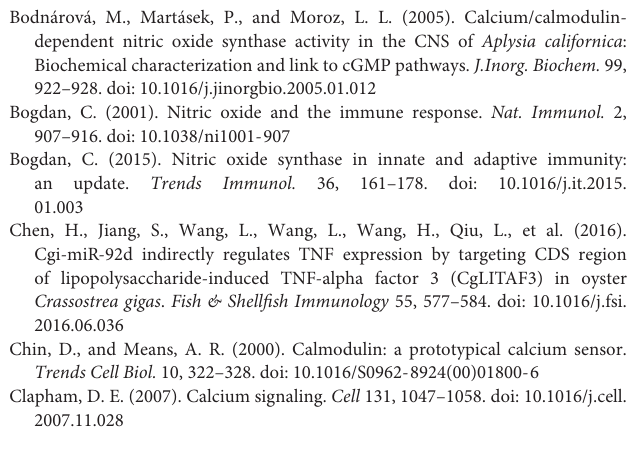
Supplementary Figure 1 | Hepatopancreas morphology after functional inhibition of CaMs and NOS. (A) HE staining of hepatopancreas from oysters before emersion stress ( N = 3). (B) HE staining of hepatopancreas from oysters after a 5-day emersion stress ( N = 3). (C) HE staining of hepatopancreas from oysters after functional inhibition of CaMs during the emersion stress ( N = 3). (D) HE staining of hepatopancreas from oysters after functional inhibition of NOS during the emersion stress ( N =